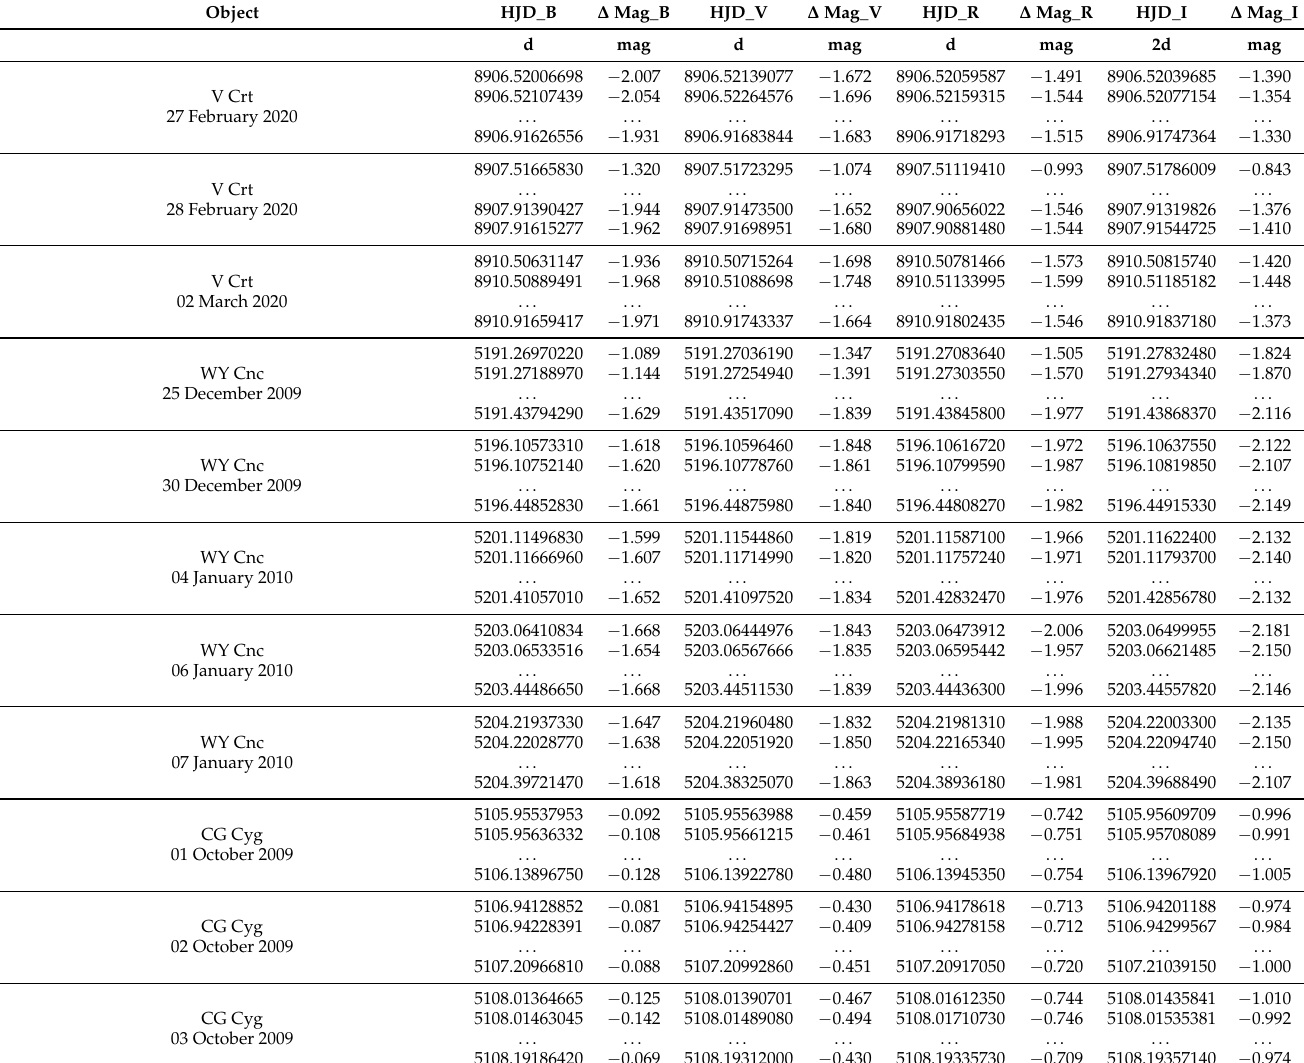
Table 2. Some examples of the observational Heliocentric Julian Date ( HJD ) and different magnitude of V Crt, WY Cnc and CG Cyg.